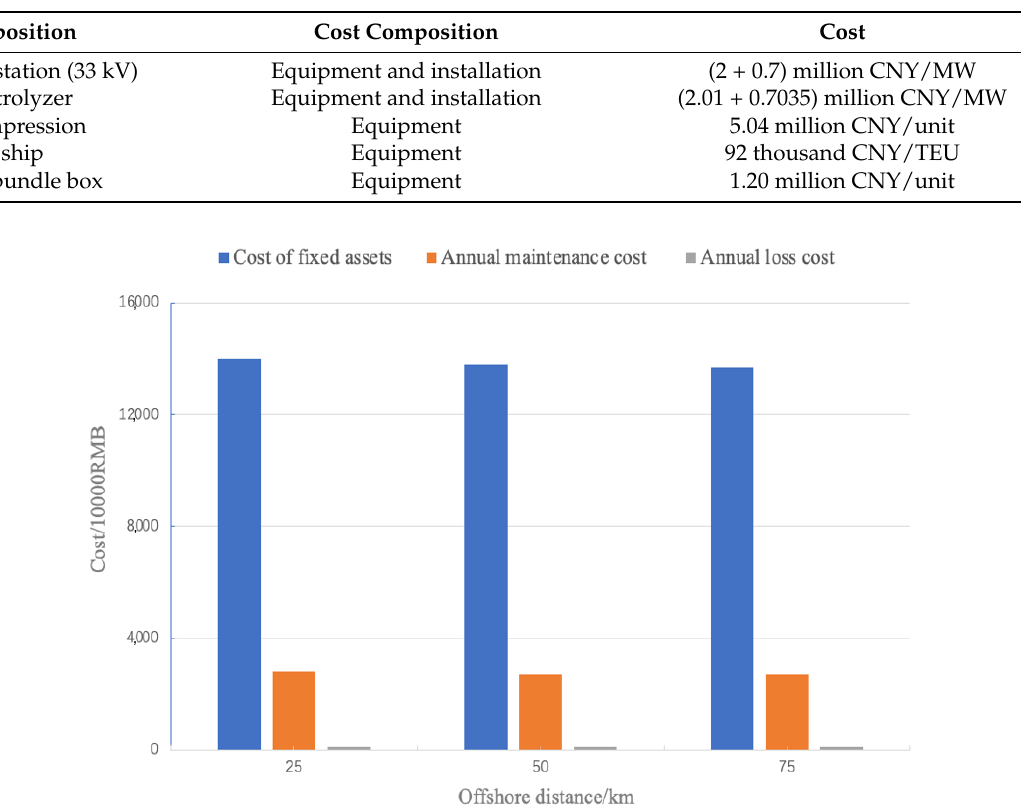
Figure 8. Cost composition of an offshore platform hydrogen production and pipeline hydrogen transmission system. Table 3. Economic parameters of an offshore platform hydrogen production and ship hydrogen transportation system.